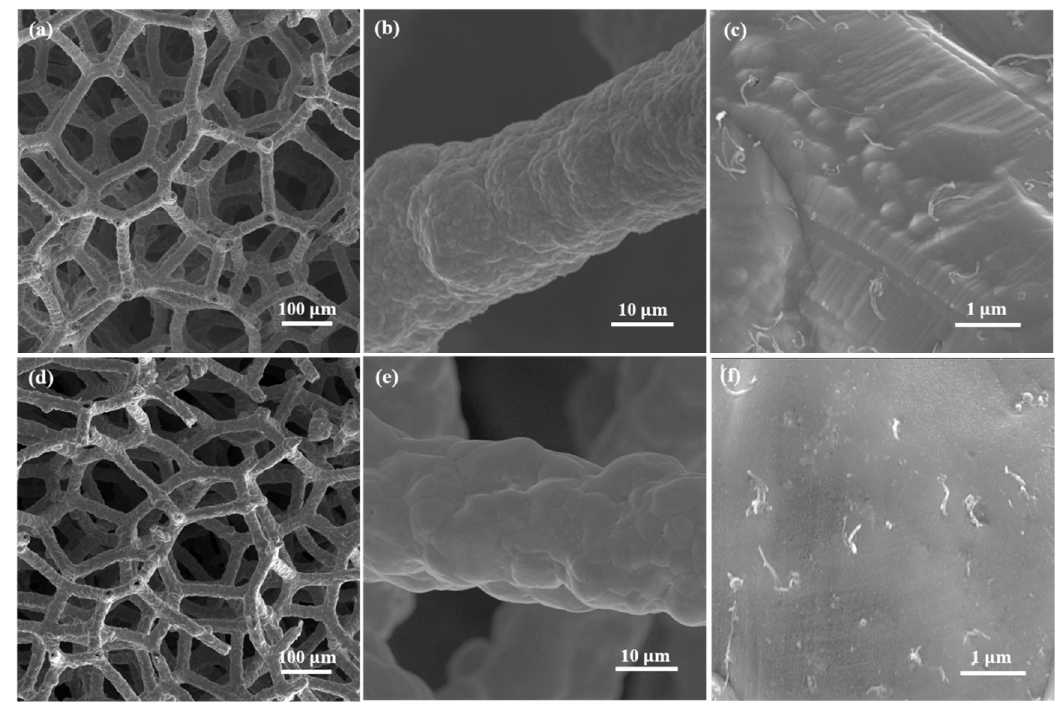
Figure 2. The SEM observation of Cu-Ni/CNTs foams at different magnifications; ( a – c ) before heat treatments; ( d – f ) after heat treatments.